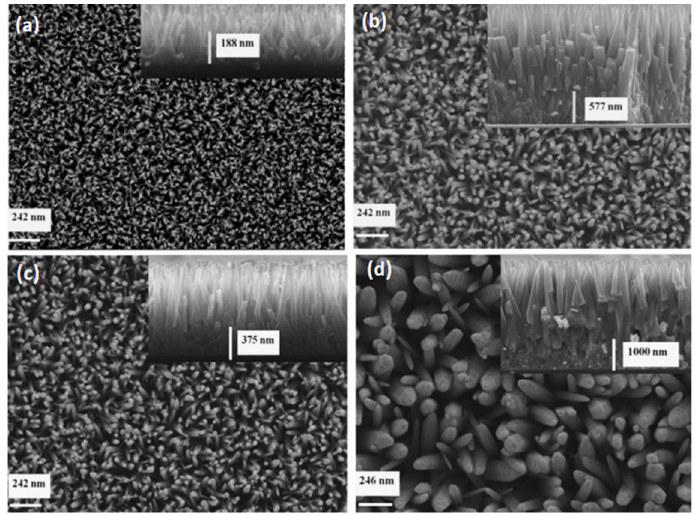
Figure 9. ( a–d ) FESEM images of ZNRs grown with different concentrations of Zn (NO 3 ) 2 6H 2 O and NH 4 OH, respectively. The insets are the corresponding cross-sectional images of the ZnO NRs. Reprinted with permission from ref. [103]. Copyright 2012 Elsevier.